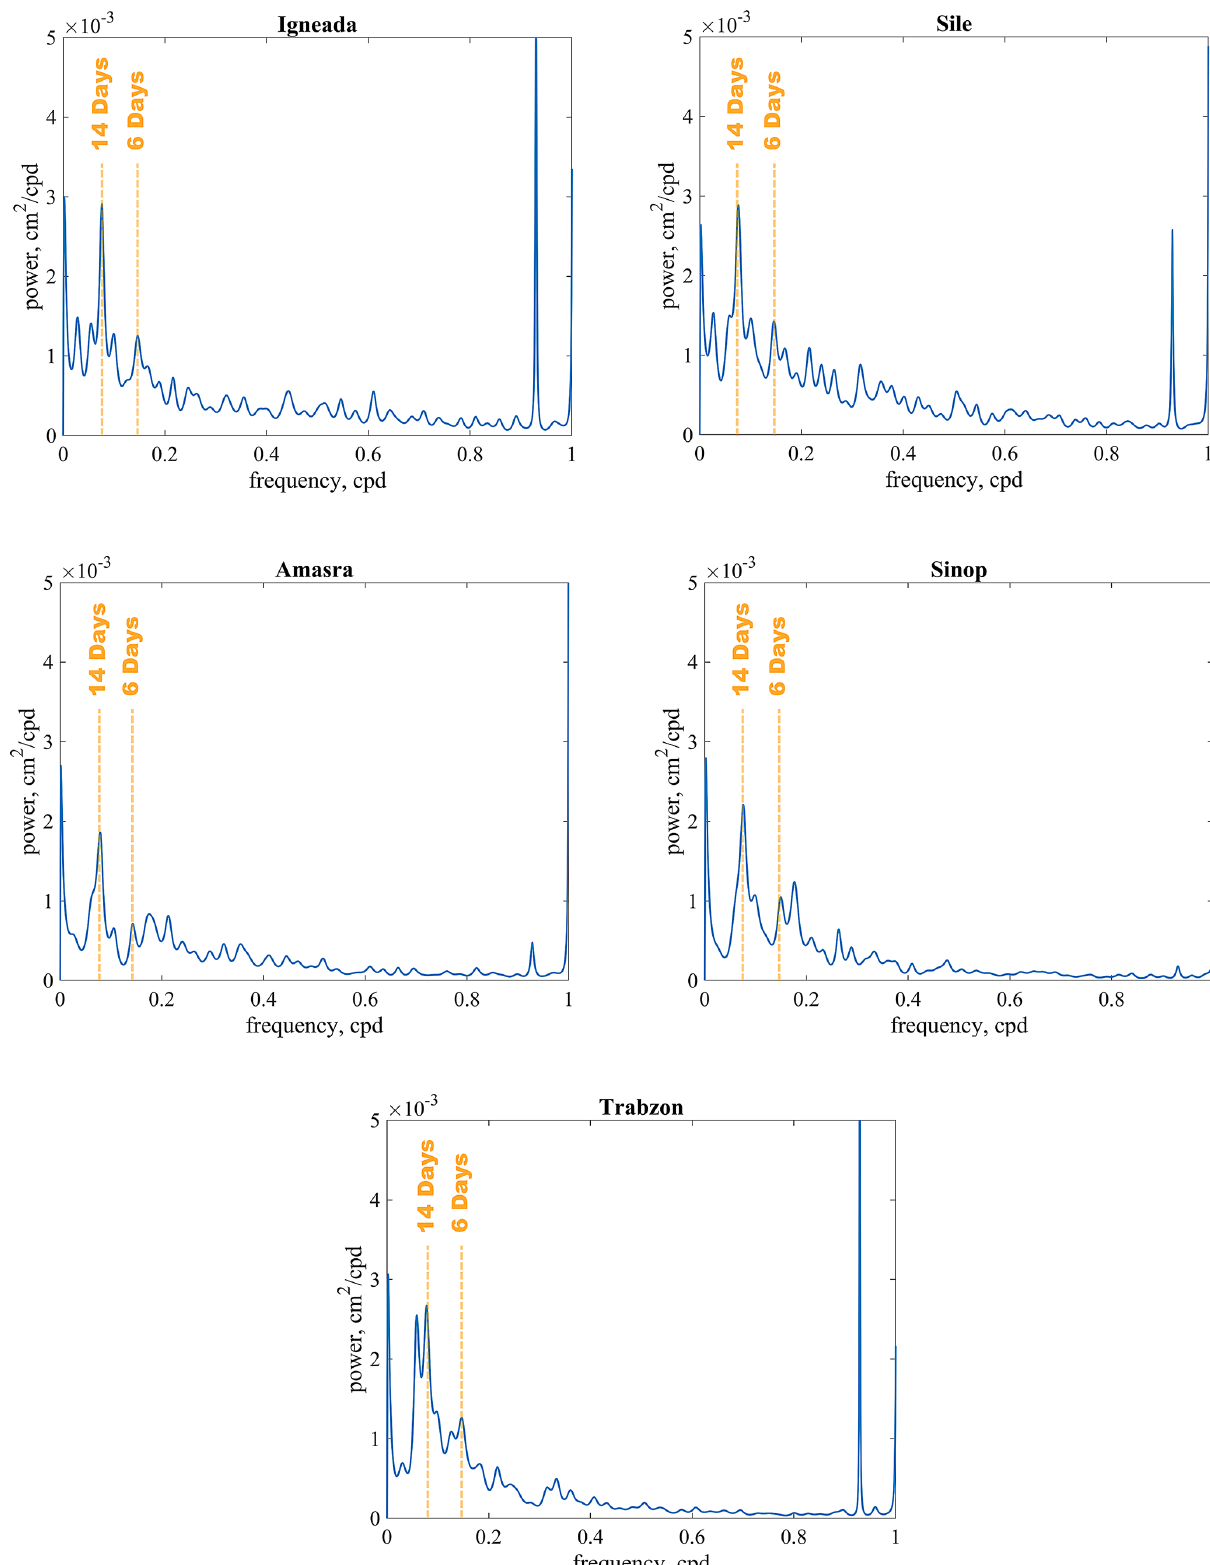
Figure 3. Variance-preserving spectra of the sea levels for ˙I˘gneada, ¸Sile, Amasra, Sinop, and Trabzon; frequency is in cycles per day (cpd).